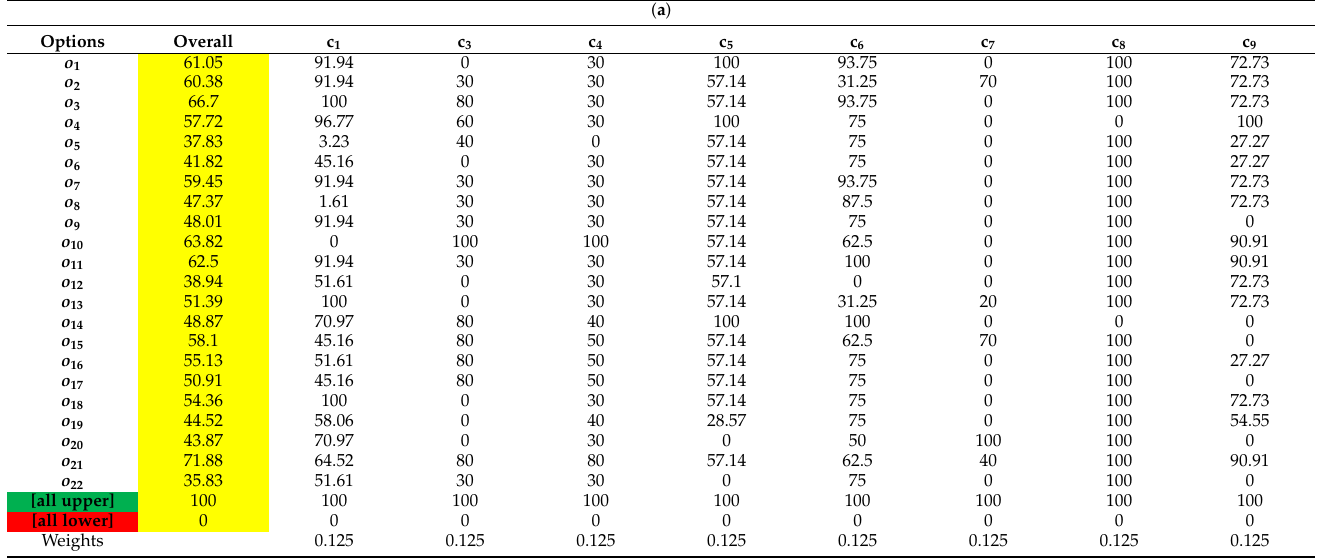
Table A3. ( a ) Third scenario—the scores of pair-wise comparisons of offers. ( b ) Third scenario— rankings of offers per